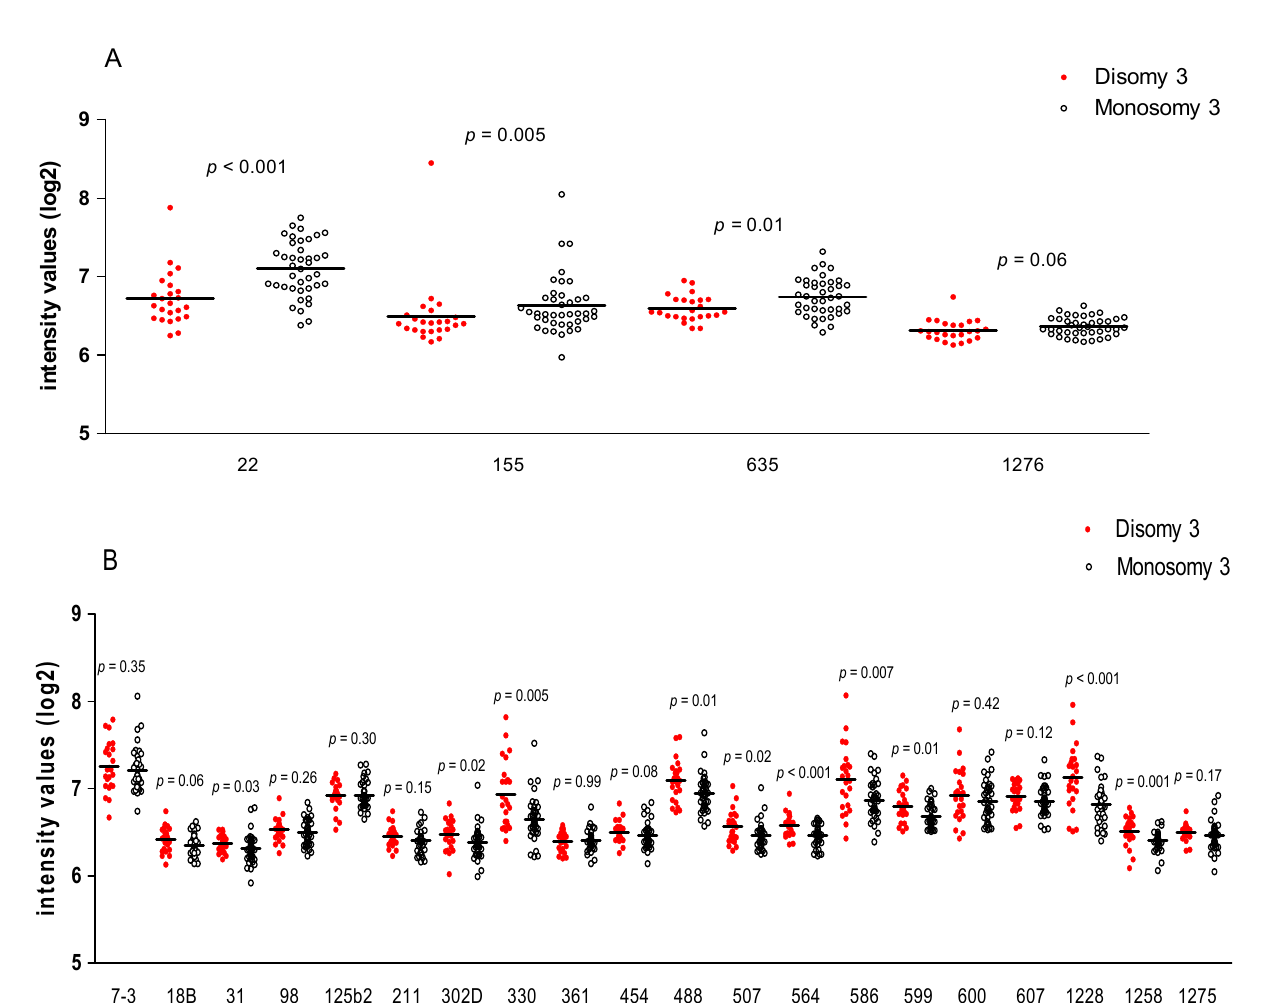
9 of 18 Figure 6. Correlation coefficients of the relation between several miRNAs and regulators of HLA expression and of members of the Antigen-Loading Machinery in the Leiden cohort. The expression of three miRNAs (miR-22, 155, 635) that are positively associated with HLA expression and of three (miR-330, 599, 1228) that are negatively associated with HLA expression were compared to Class I Regulatory Factors and members of the Antigen-Loading Machinery. The correlation coefficients based on Spearman correlations ( n = 64) are shown. The intensity of colors indicates the strength of the correlation, with red indicating positive and blue negative correlations. 3.4. MiRNA Expression and Chromosome 3 Status As we and others [10–12] have shown that an inflammatory infiltrate is associated with M3, we subsequently determined whether the differential expression of miRNAs was related to the tumour chromosome 3 status. Of the four miRNAs which were high in